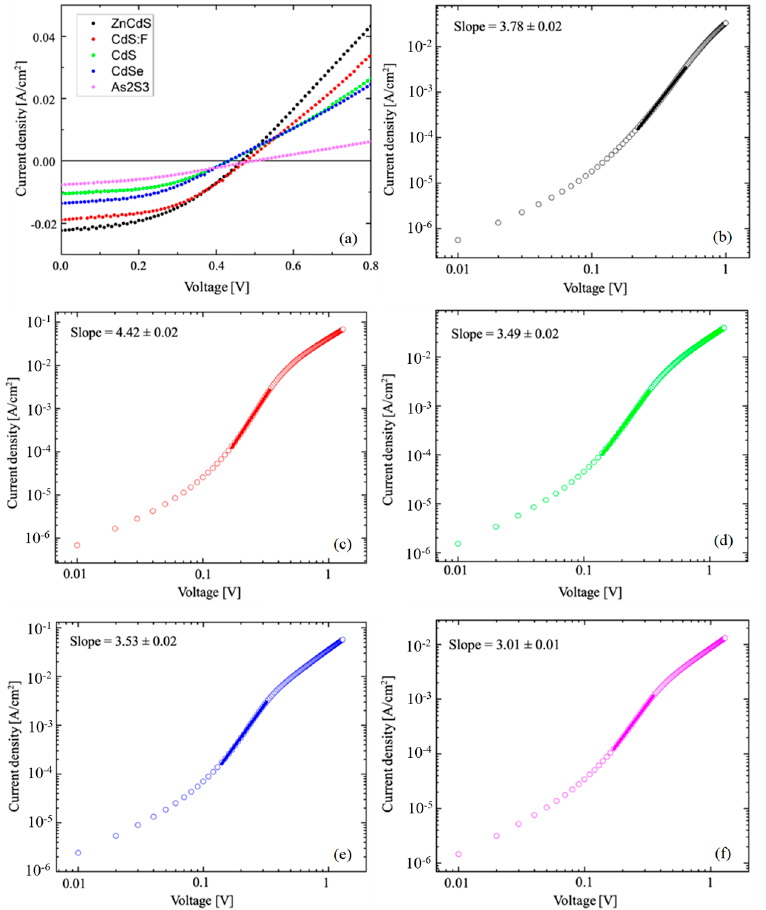
Figure 6. ( a ) J-V characteristics of the solar cells fabricated with different window layers; ( b-f ) Dark J-V curves in log scale. The fit (solid lines) was performed to extract the Trap Filling Limit Voltage (V TFL ) value (see text). ( b ) ZnCdS; ( c ) CdS:F; ( d ) CdS; ( e ) CdSe; ( f ) As 2 S 3 .